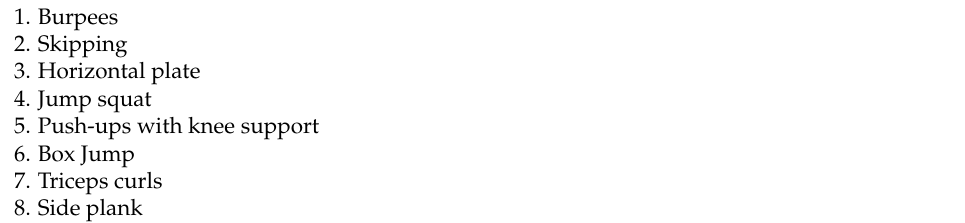
Table 1. Strength exercises based on CrossFit